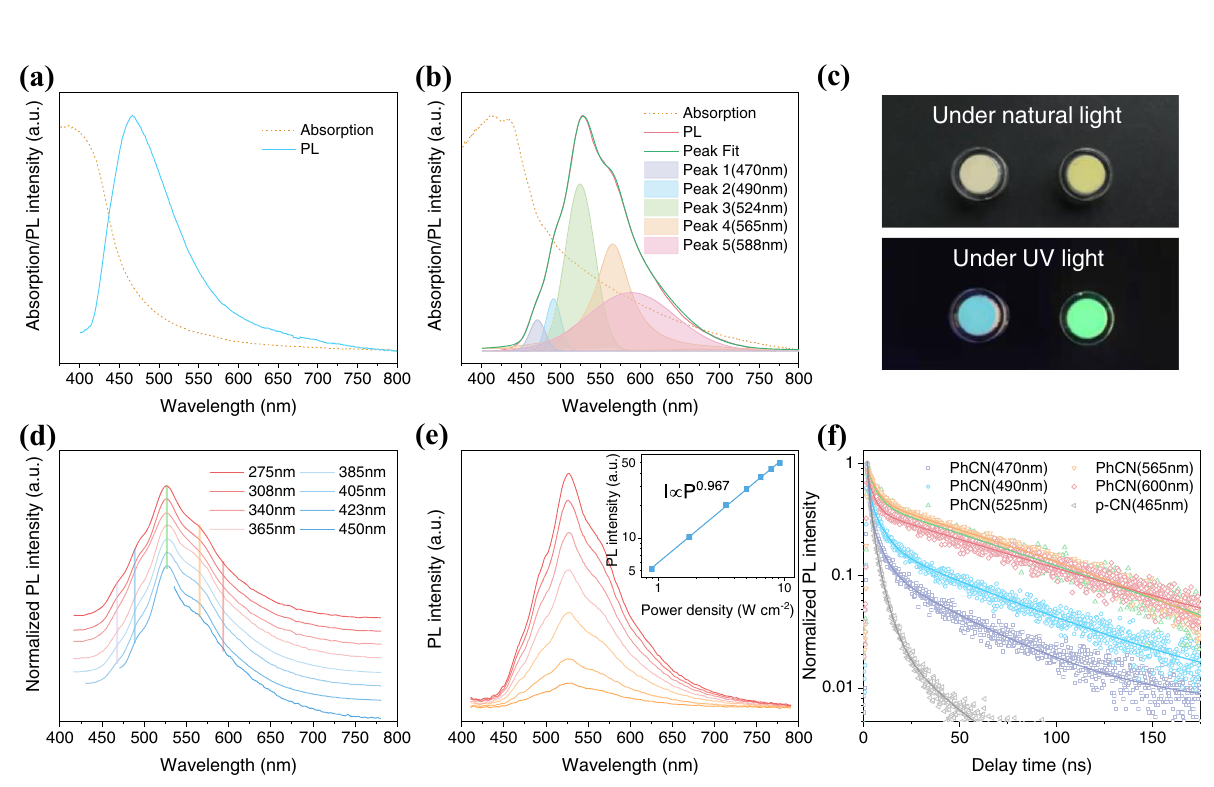
Fig.3|Opticalpropertiesofg-CNmaterials. UV – VisabsorptionandPLspectraof a p-CN and b PhCN. c Photographs of p-CN (left) and PhCN (right) powders under naturallightand365nmUVlight. d NormalizedPLspectraofPhCNunderdifferent